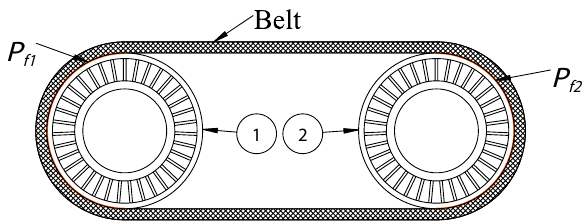
Figure 2. Two-pulley-one-belt system.